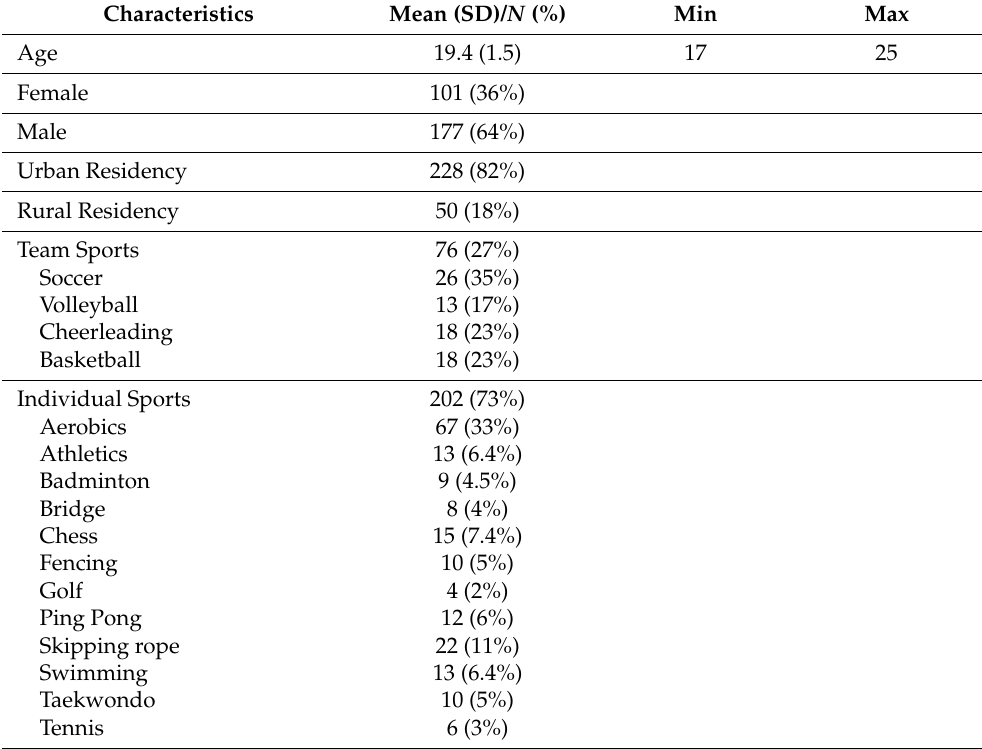
Table 1. Sample Characteristics Data are n (%) or Mean (sd). N =